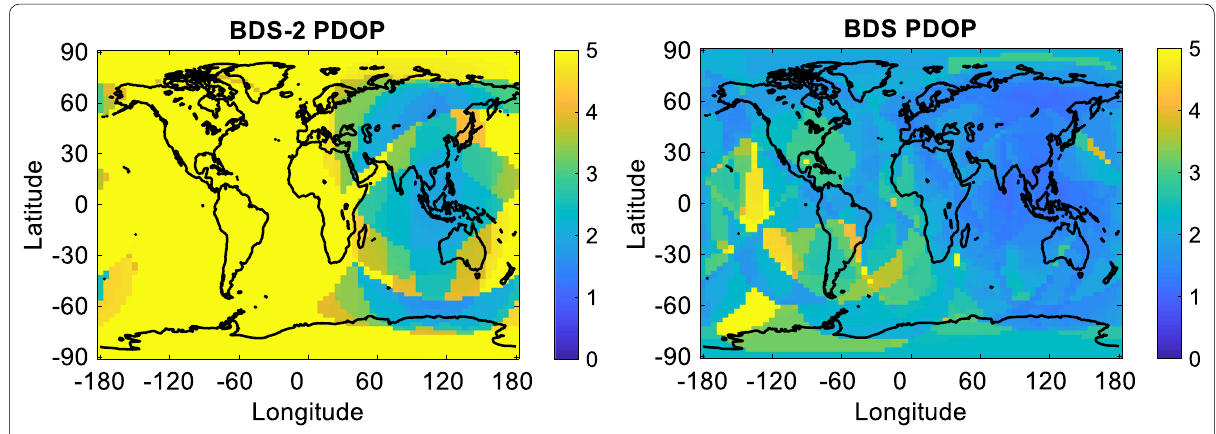
Fig. 1 Distribution of PDOP values for BDS-2 (left) and BDS (right) constellation at 12:00 UTC, DOY 20,